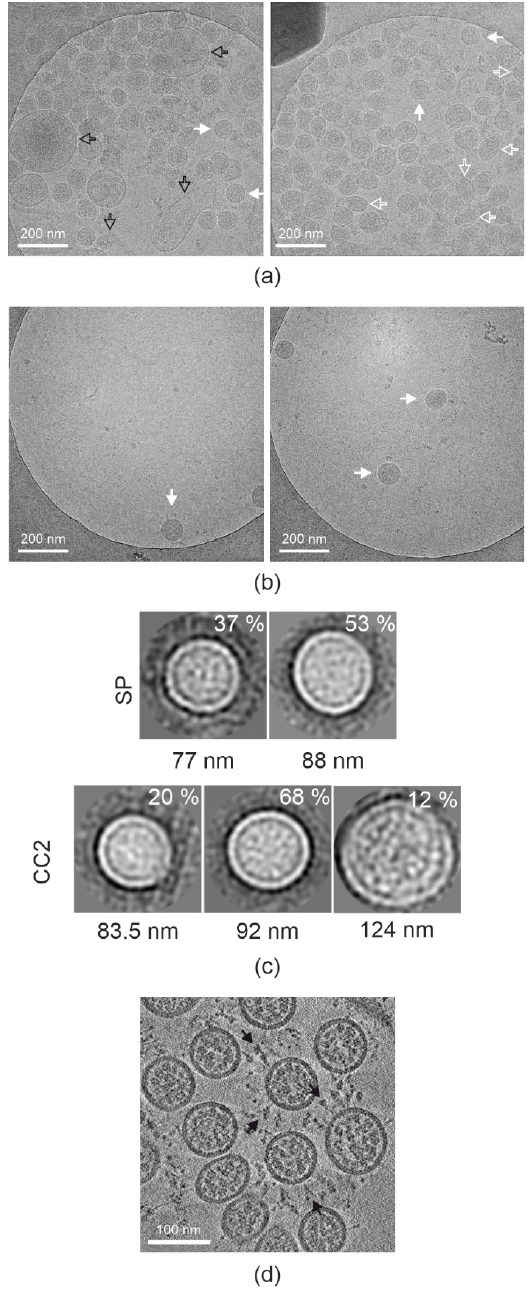
Figure 3. Morphology of inactivated SARS-CoV-2 particles. ( a ) Representative micrographs of SP SARS-CoV-2. ( b ) Representative micrographs of CC2 purified and concentrated SARS-CoV-2. ( a , b ) Images taken at − 6 μ m defocus; Intact SARS-CoV-2 particles (full white arrows), deformed particles (empty white arrows), and contaminating cellular derivatives (empty black arrows) are indicated. ( c ) Class averages of 100 particles picked from the imaged SP micrographs in the top row, and from 100 particles picked from the imaged CC2 concentrated micrographs in the bottom row. The per- centage of the particles in the class is shown inside each box, and the average diameter of each class is shown below the box. The box size is 140.25 nm × 140.25 nm. ( d ) A section through a tomogram of concentrated Capto Core 2× purified SARS-CoV-2. Pre-fusion spikes are indicated by full black arrows. Tomogram was collected at − 3 μ m defocus.